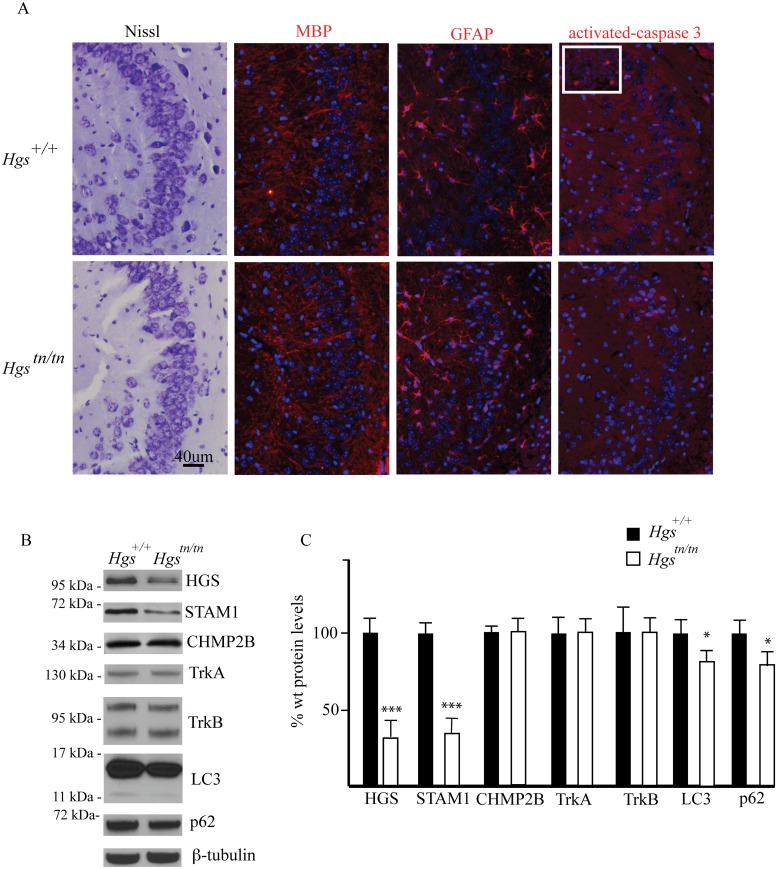
Comparison of hippocampal structure and protein expression between Hgs
tn/tn and Hgs
+/+ mice.(A) CA3 hippocampal sections from 4-week-old Hgs
+/+ and Hgs
tn/tn mice were stained for Nissl, myelin basic protein (MBP), glial fibrillary protein (GFAP) and activated caspase 3. Inset is positive control (E13 embryo) for activated caspase-3. Nuclei are stained with DAPI (blue). (B) Representative immunoblot of hippocampal lysates from 4-week-old Hgs
+/+ and Hgs
tn/tn mice. Blots were probed for the ESCRT components HGS, STAM1, and CHMP2B, the receptor tyrosine kinases TrkA and TrkB, and the autophagic markers LC3 and p62. (C) Quantitation of immunoblots from hippocampal lysates. n = 3 mice per genotype. Data are shown as mean ± SE. *p<0.05 and ***p<0.001.